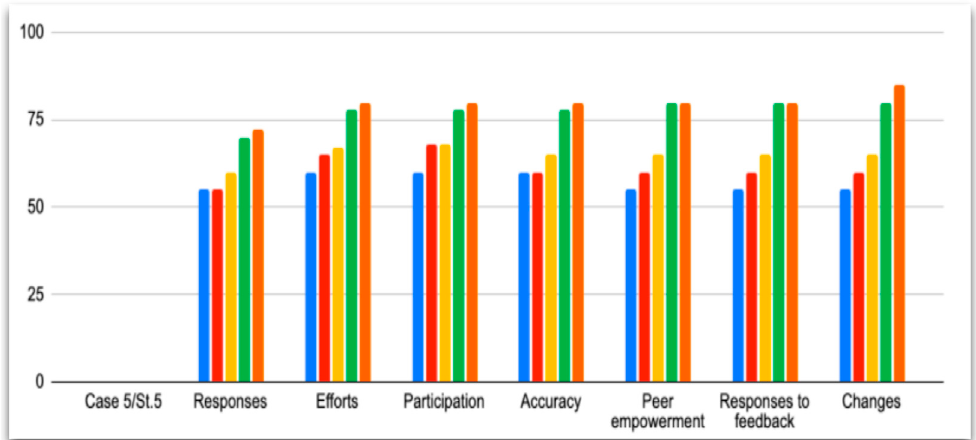
Figure 5. Vocabulary and spelling progress during alternative assessment online/Case 5.